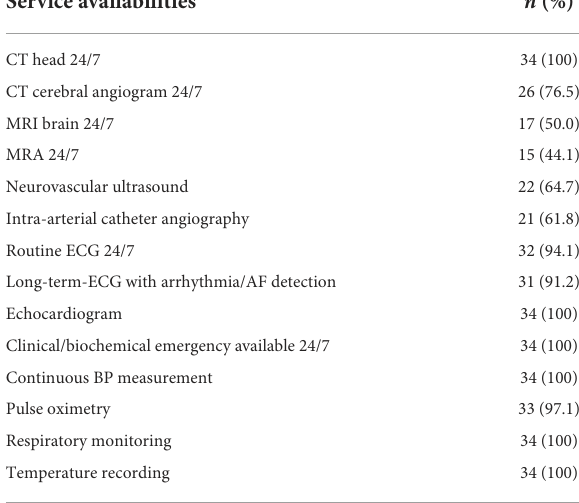
TABLE 2 Neuroimaging and monitoring services at surveyed